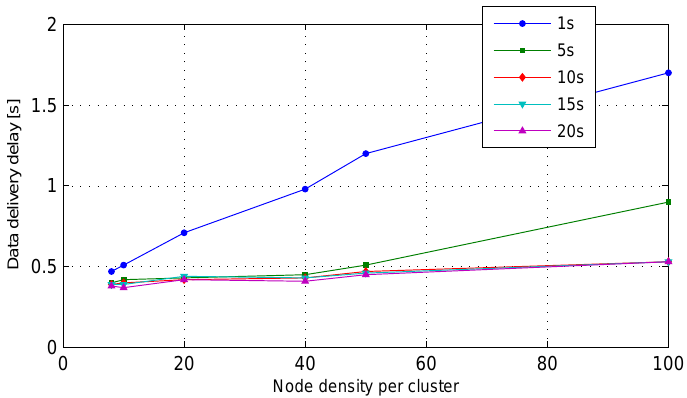
Figure 14. Packet delivery delay variation with cluster